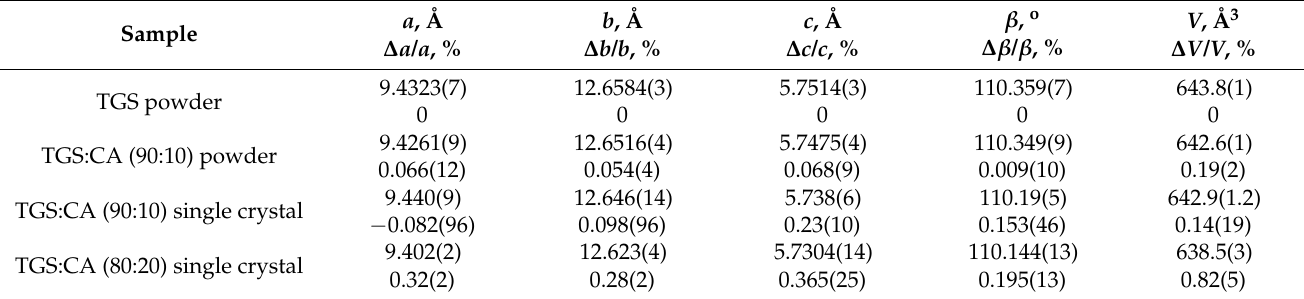
Table 6. Unit cell parameters of TGS, TGS:CA (90:10) and TGS:CA (80:20) crystals and relative changes of parameters caused by CA doping according to single crystal and powder XRD experiments.